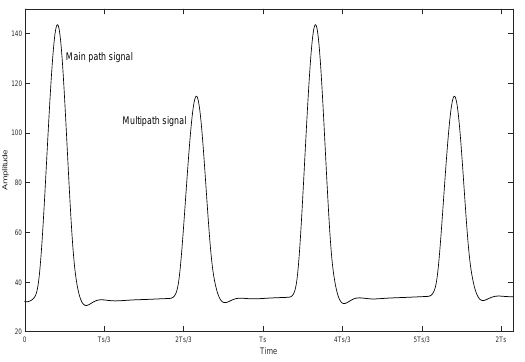
Figure 7. Waveform of two symbol periods after the received signal is